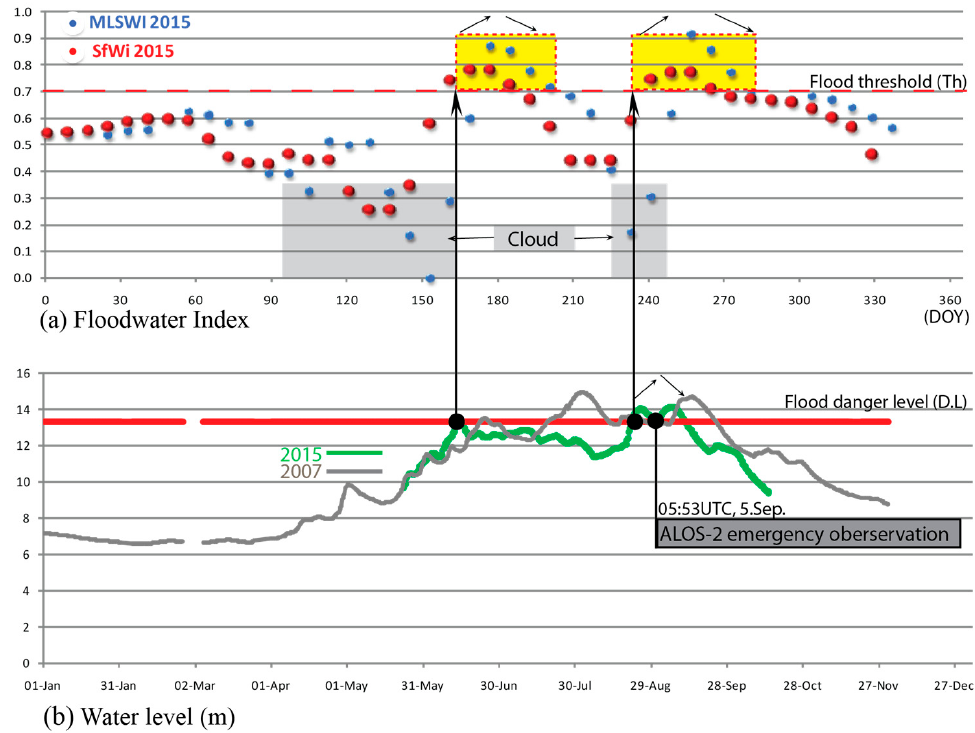
Figure 3. Mean annual SfWi change between MLSWI and water level in selected Sirajganj sites.